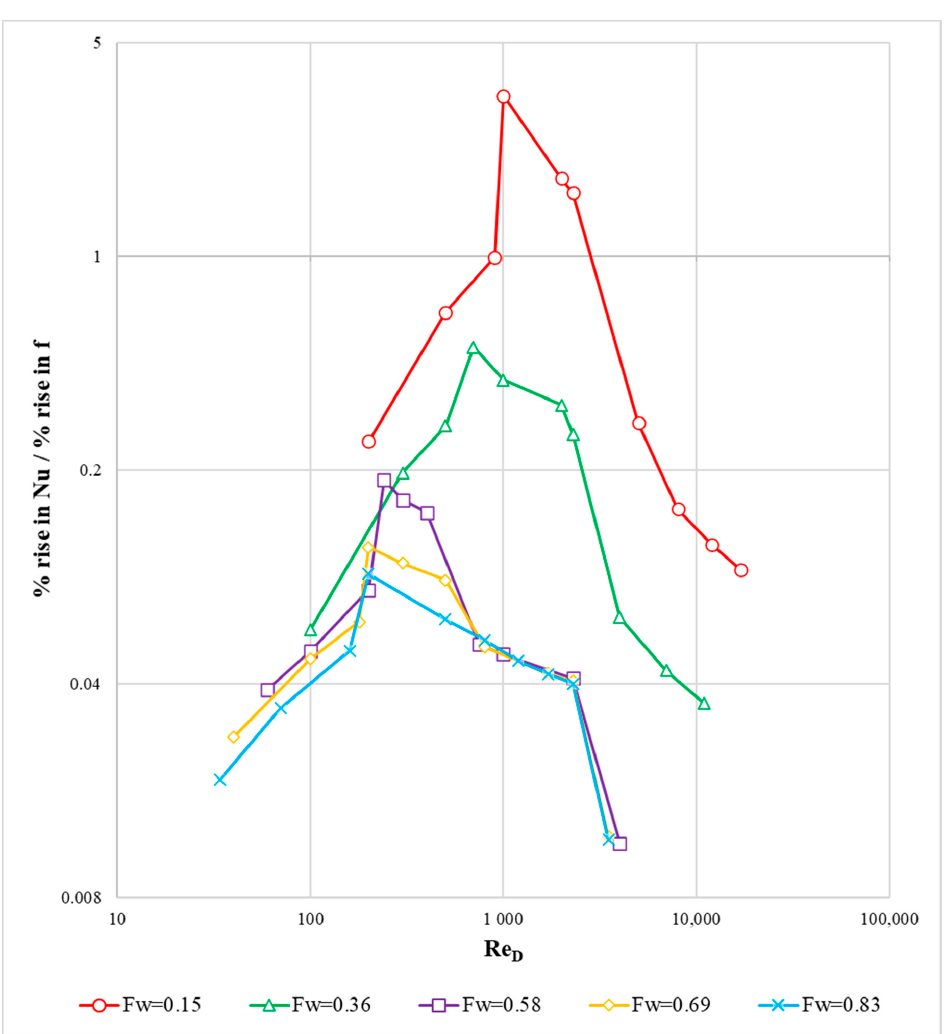
Figure 14. Relationship between thermal and hydrodynamics performance of wavy-walled tubes.